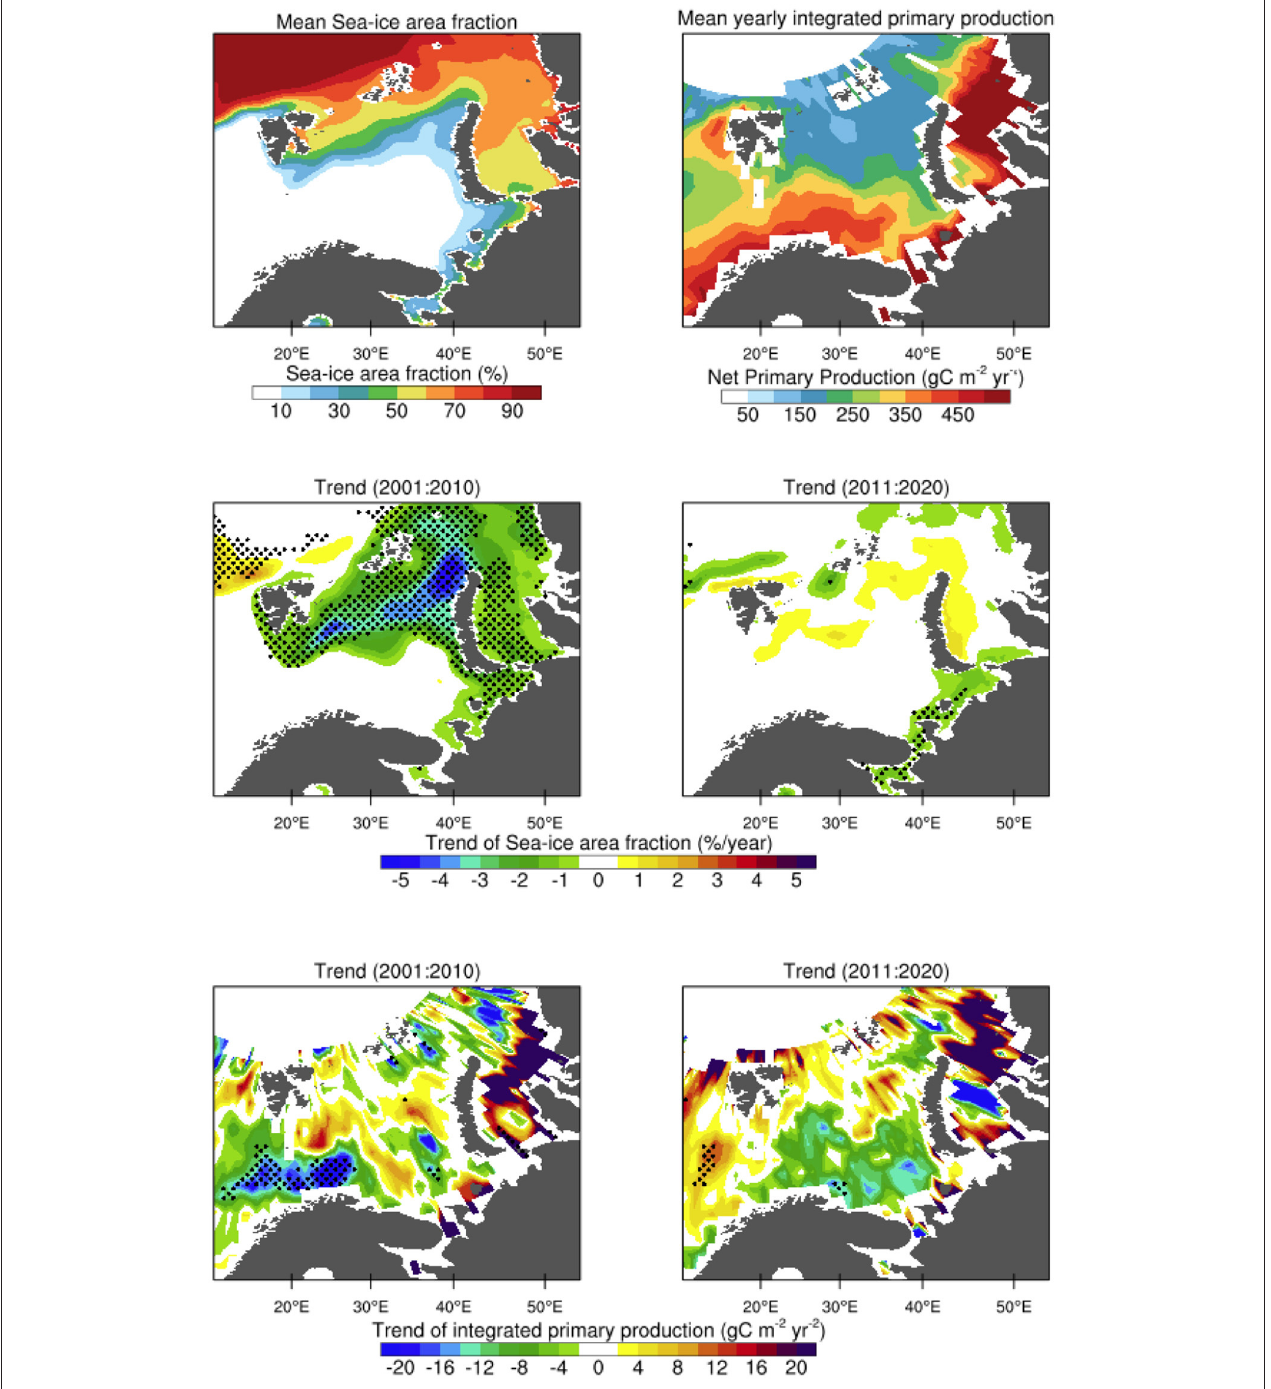
FIGURE 8 | Climatology of the annual mean sea-ice concentration and integrated net primary production (gCm − 2 yr − 1 ) for the period 1997–2020 from satellite observations. Trends in annual mean sea-ice concentration (second row) and integrated net primary production (third row) for the two periods 2001–2010 and 2011–2020. The stippling marks statistically significant trends at 90% confidence